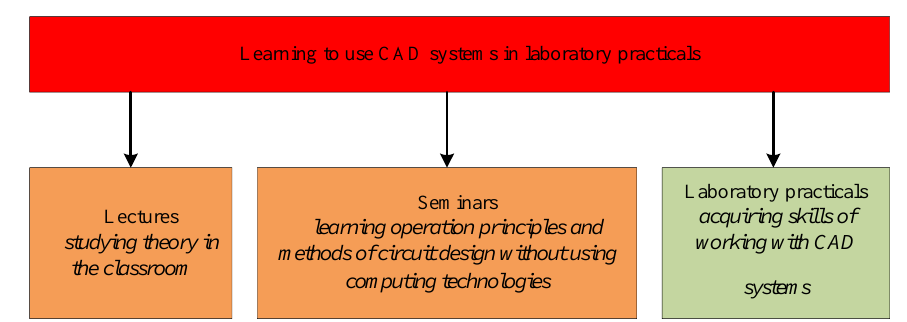
Fig. 2. Alternative approach to the distribution of learning material in the curriculum.